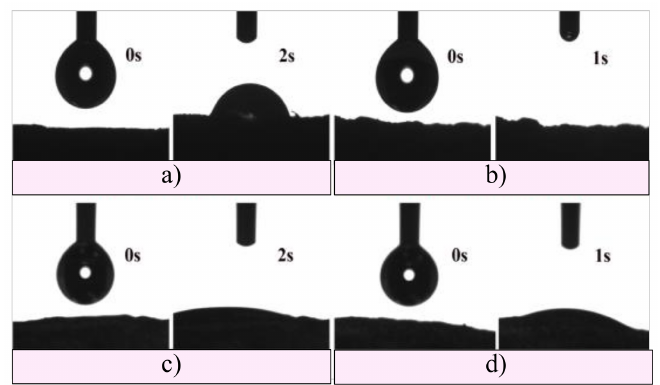
Figure 5. Hydrophilicity of ( a ) GH, ( b ) A50G50H, ( c ) GH/HAp, and ( d ) A50G50H/HAp hydro- gel